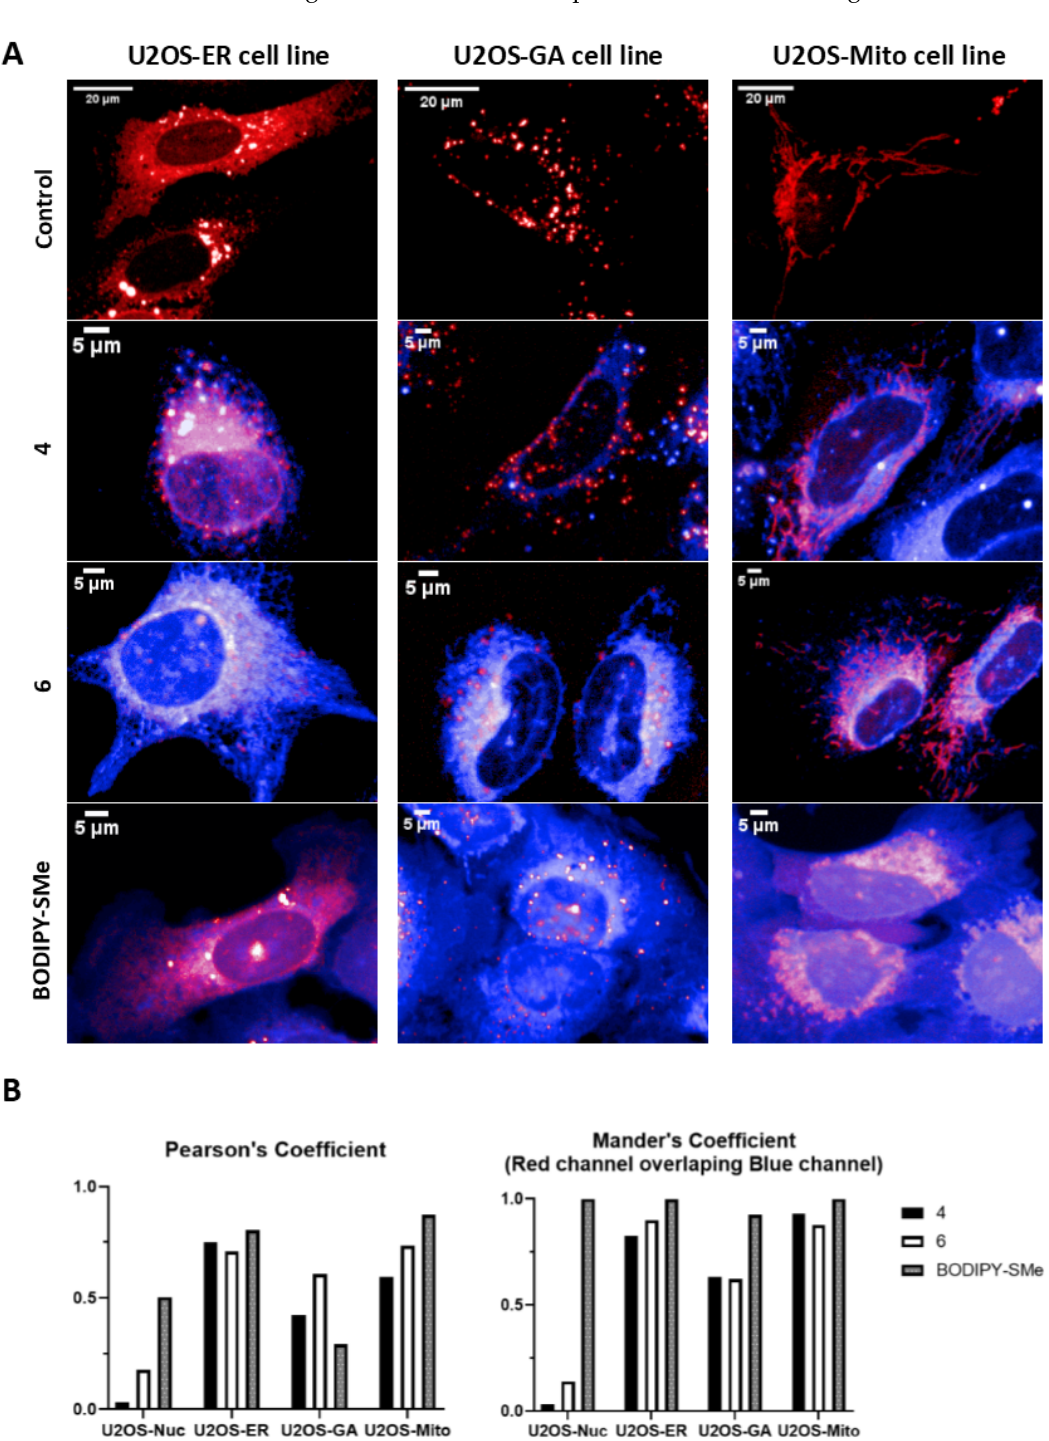
Figure 5. Live cell imaging and colocalization experiments of active compounds ( 4 , 6 ) and BODIPY-SMe (panel A ) and visualization of Pearson´s and Mander´s coefficient (panel B ).